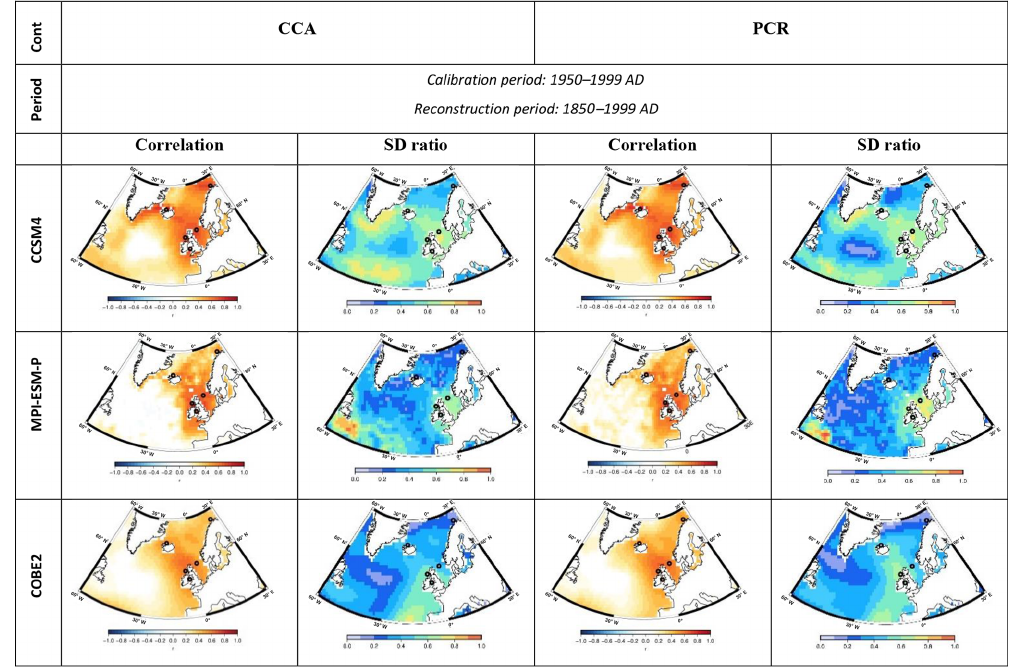
Figure 3. Same as in Fig. 1 but for the noise-contaminated